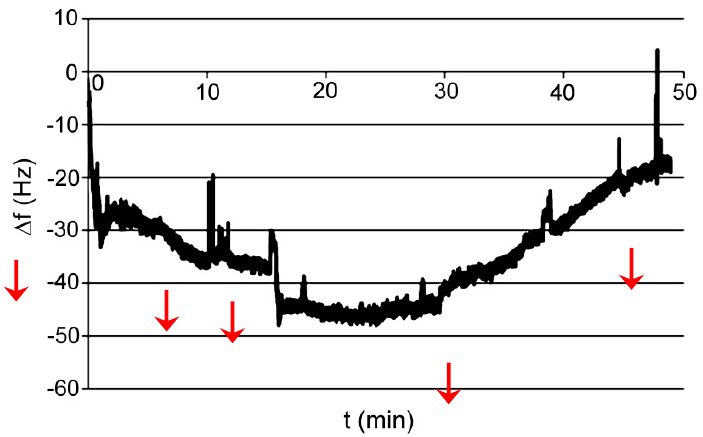
Figure 11. Changes of frequency in time for AP I polymer; absorbed compound—acetyl salicylic acid in a buffer.